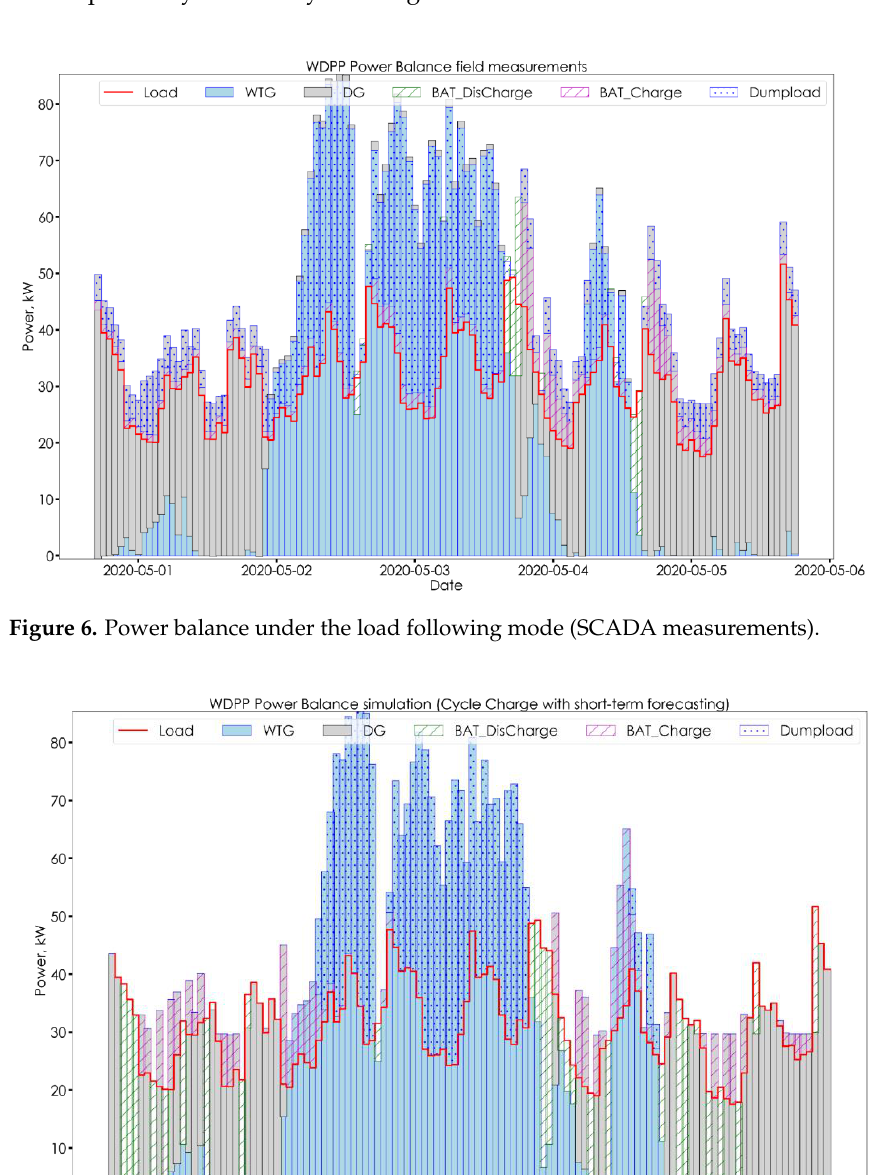
Figure 7. Power balance under the cycle charge and short-term forecasting mode (simulation).